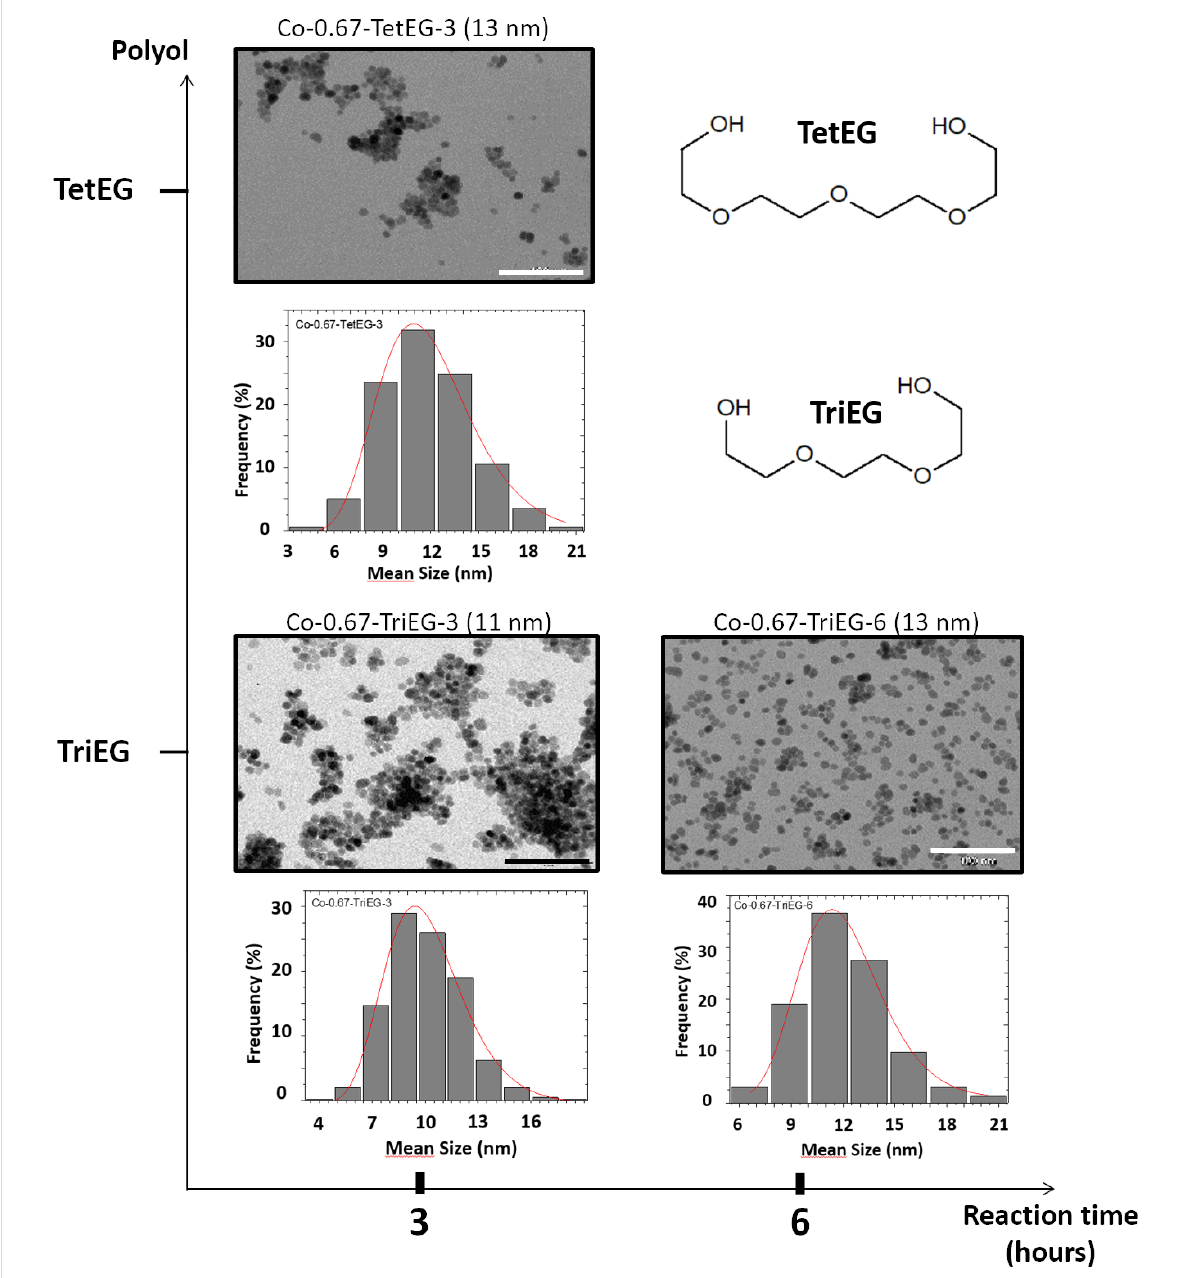
Figure 4: TEM images of Co 0.67 Fe 2.33 O 4 NPs as a function of the polyol nature and the reaction time, and the corresponding diameter distributions and log-normal fits. Scale bar = 100 nm. The formulas of the polyols are given in the insert.